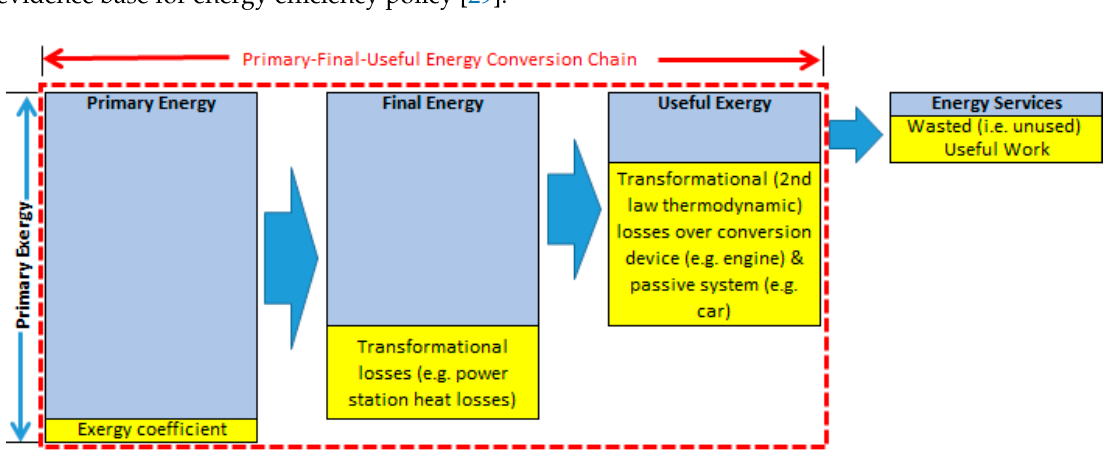
Figure 1. Primary-to-final-to-useful energy conversion stages. Adapted from Figure 1 . Primary-to-final-to-useful energy conversion stages. Adapted from [30].